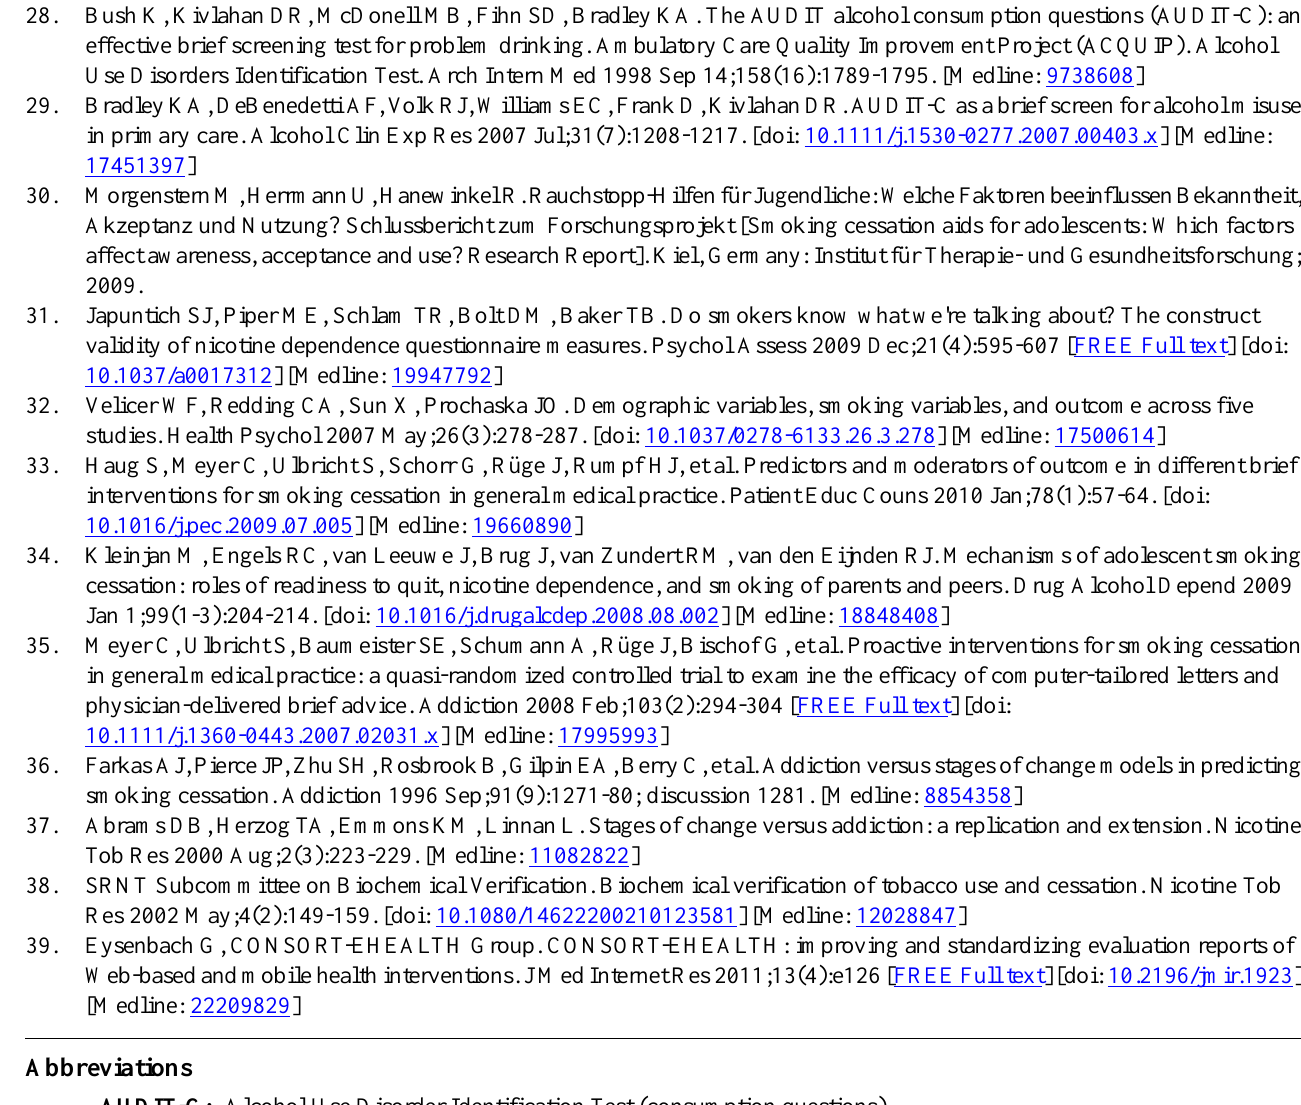
AUDIT-C: Alcohol Use Disorder Identification Test (consumption questions) CCA: complete-case analyses HAPA: Health Action Process